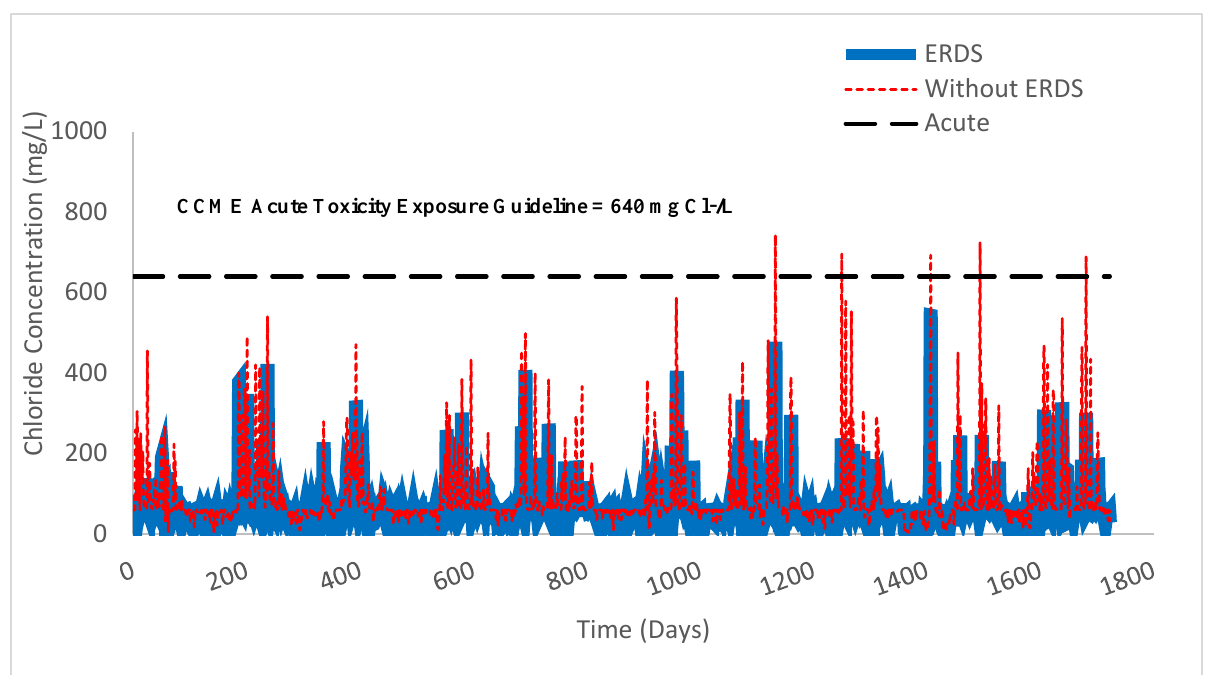
Figure 9. Average daily chloride concentration in the receiving stream with and without ERDS for ten winter seasons.